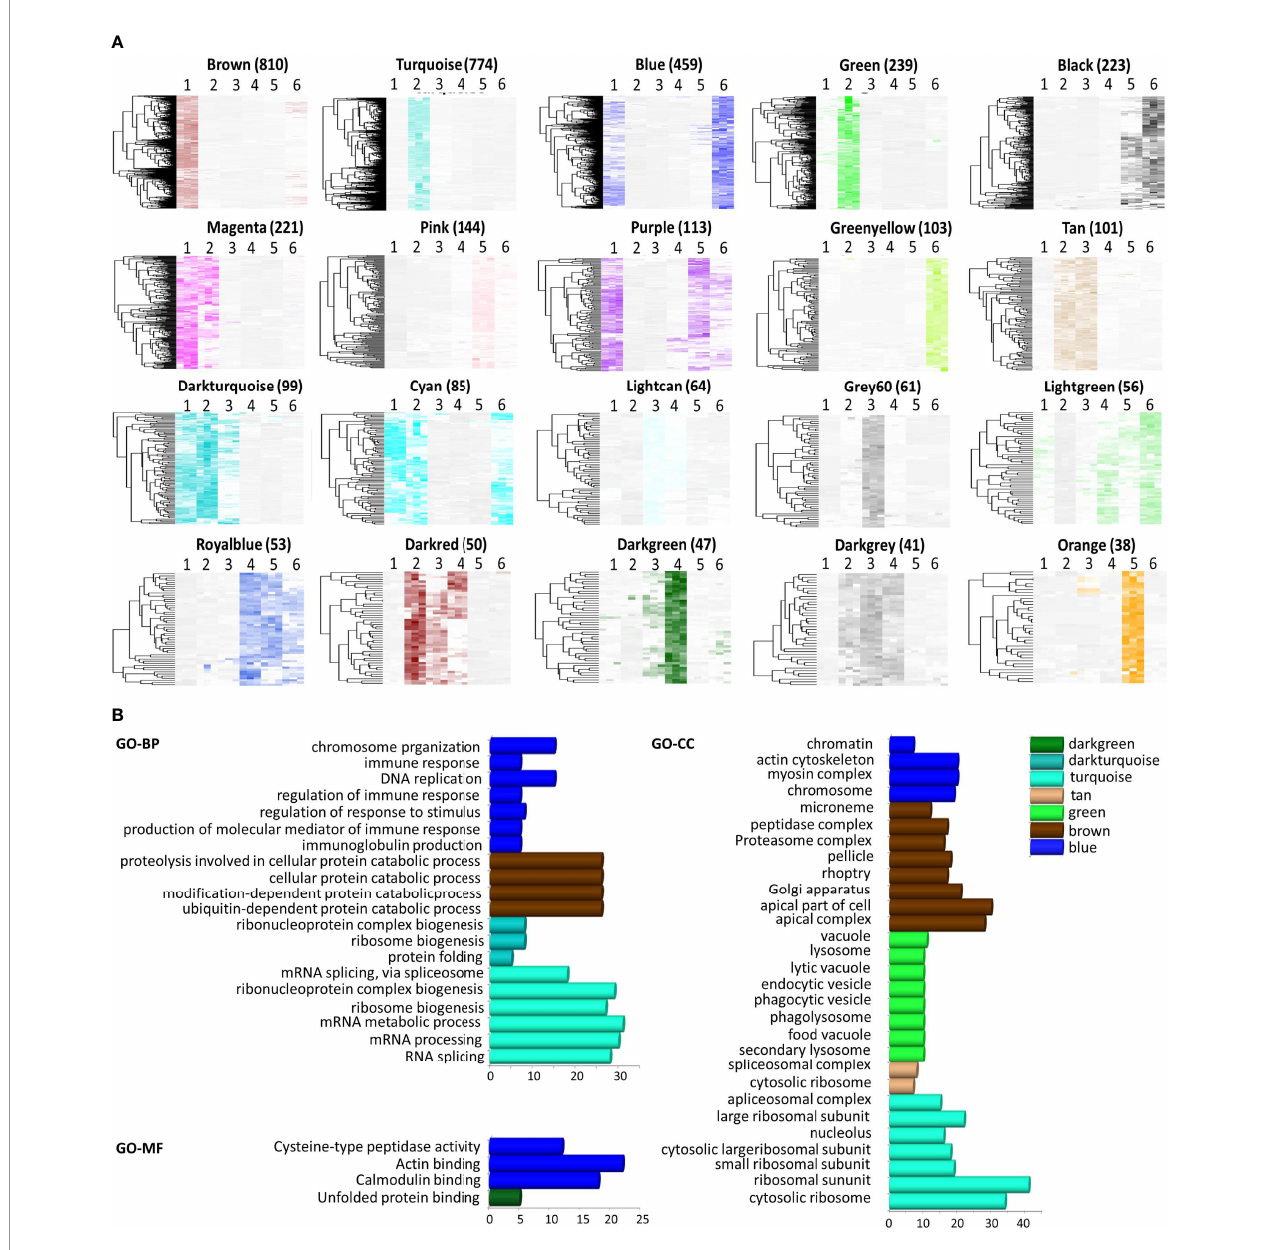
FIGURE 2 | Module features and functional annotation of genes in the modules. Modules comprising genes with similar expression patterns were identi fi ed by weighted gene coexpression network analysis. (A) Heatmap of genes in each module (Number of genes was showed in parentheses). The samples were arranged as 1, merozoite, 2, early-ring, 3, late-ring, 4, early-trophozoite, 5, late-trophozoite, and 6, middle-schizont (three replicates for each stage). (B) Gene ontology (GO) enrichment analysis, including biological processes (BP), cellular component (CC), and molecular function (MF), for the genes comprised in each